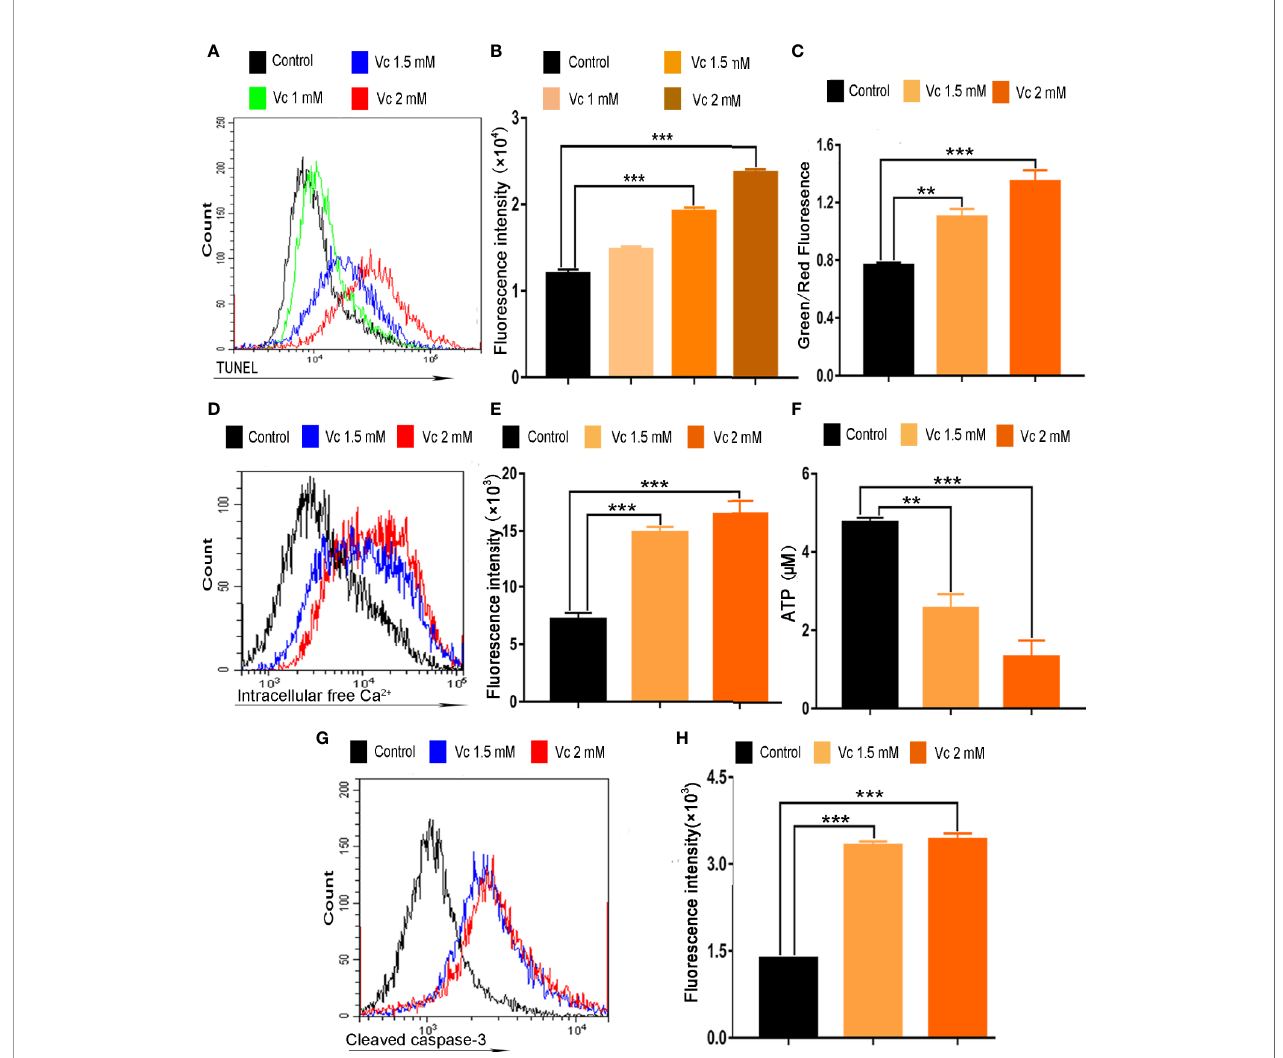
FIGURE 7 | Vitamin C induces apoptosis of ID8 cells. (A) The fl uorescence pattern of terminal deoxynucleotidyl transferase-mediated dUTP nick end labeling (TUNEL) – stained ID8 cells. (B) Cell associated mean fl uorescence intensities of TUNEL-stained ID8 cells. (C) Effect of vitamin C on mitochondrial membrane potential in ID8 cells. (D) The fl uorescence pattern of Fluo-4/AM-stained ID8 cells. (E) Cell associated mean fl uorescence intensities of Fluo-4/AM-stained ID8 cells. (F) The levels of ATP in ID8 cells. (G, H) ID8 cells were stained with cleaved caspase-3 (Asp175) antibody (Alexa fl uor 488 conjugate). (G) The fl uorescence pattern of ID8 cells. (H) Cell associated mean fl uorescence intensities. Data are mean ± SEM; n=4. **p < 0.01, ***p <